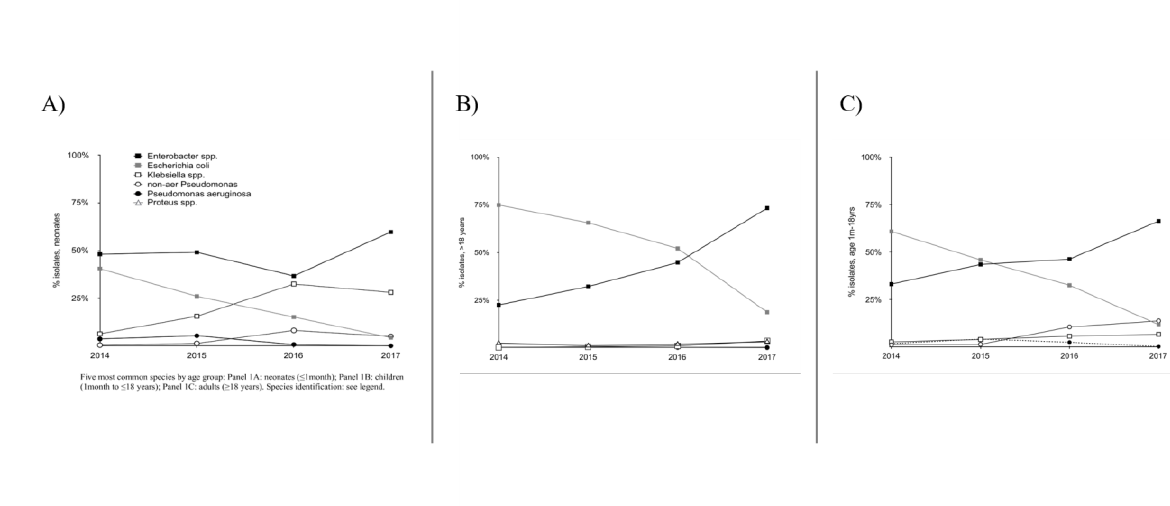
Figure 1. Five most common species by age group: Panel 1A: neonates (≤1month); Panel 1B: children (1month to ≤18 years); Panel 1C: adults (≥18